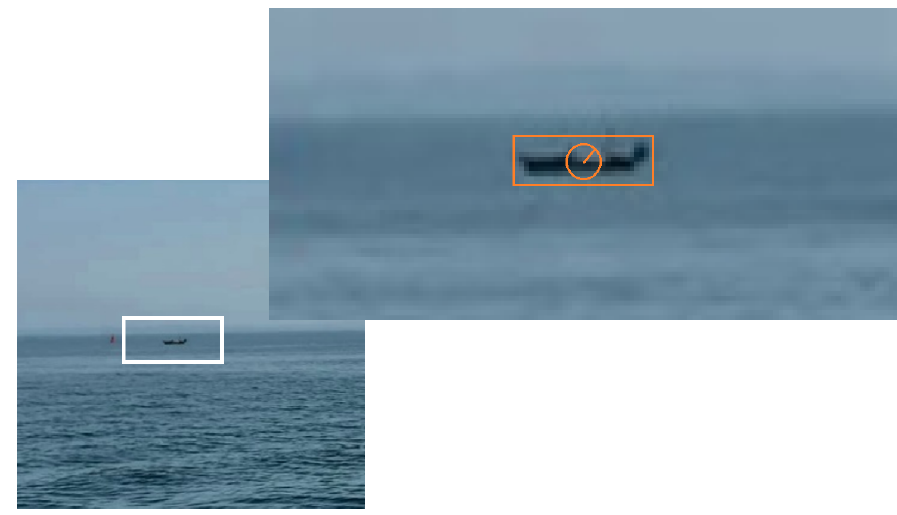
Figure 2. Using the distribution of center points to indicate the position of the